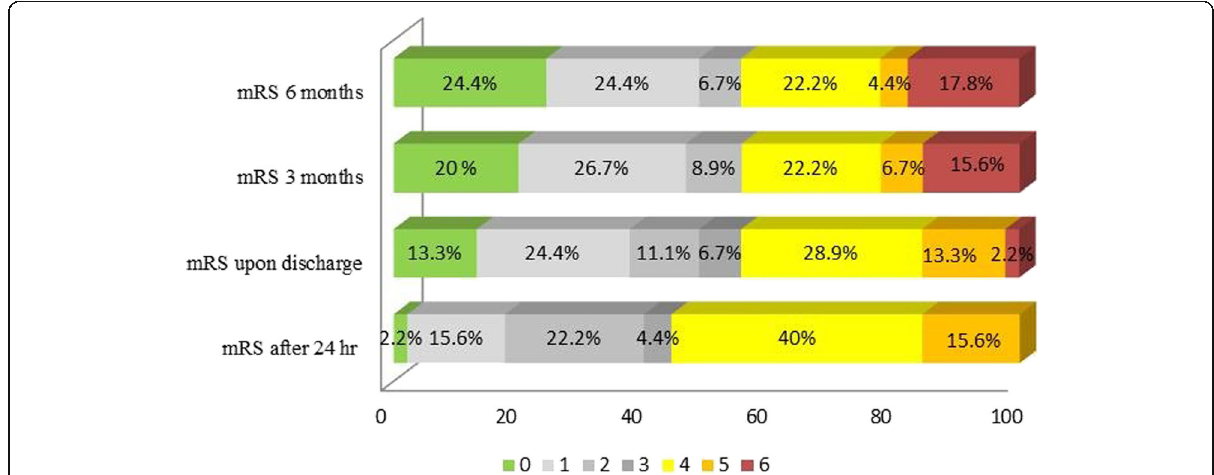
Fig. 1 Percentages of each mRS value among the group of patients studied at different time